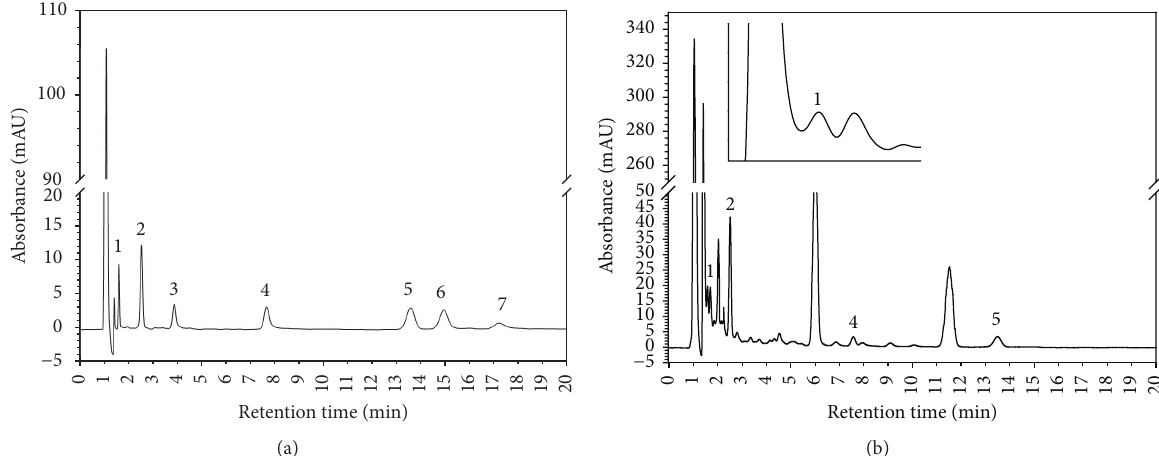
Figure 3: High performance liquid chromatography (HPLC) chromatogram of flavonoid standards (a) and tomato sample; Betatniy (b). Peak identification 1: rutin; 2: quercetin; 3: myricetin; 4: luteolin; 5: naringenin; 6: apigenin; and 7: